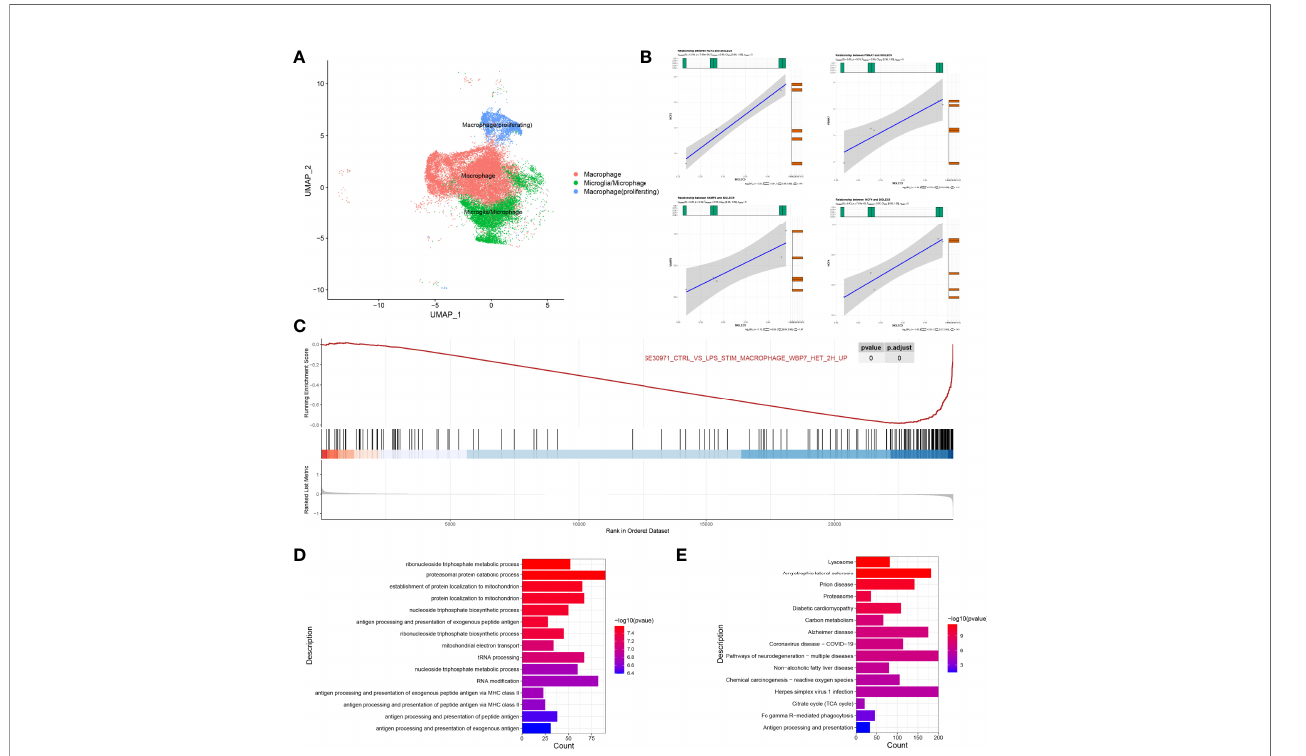
FIGURE 7 | Regulatory role of SIGLEC9 in macrophages with glioma. (A) Uniform Manifold Approximation and Projection plot of macrophage cluster. (B) Correlation between SIGLEC9 and macrophage activation genes (NCF2, PSMA7, VAMP3, and NCF4). (C) Gene Set Enrichment Analysis between high- and low-SIGLEC9 groups in macrophages. (D) Gene Ontology analysis between high- and low-SIGLEC9 groups in macrophages. (E) Kyoto Encyclopedia of Genes and Genomes analysis between high- and low-SIGLEC9 groups in